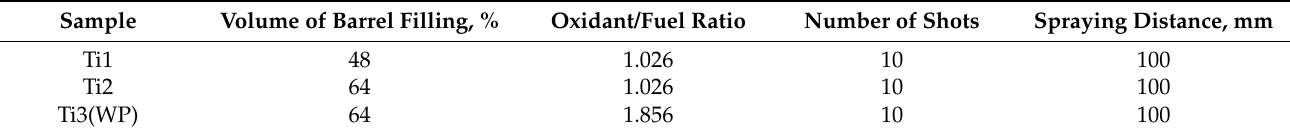
Table 2. Technological parameters for obtaining Ti